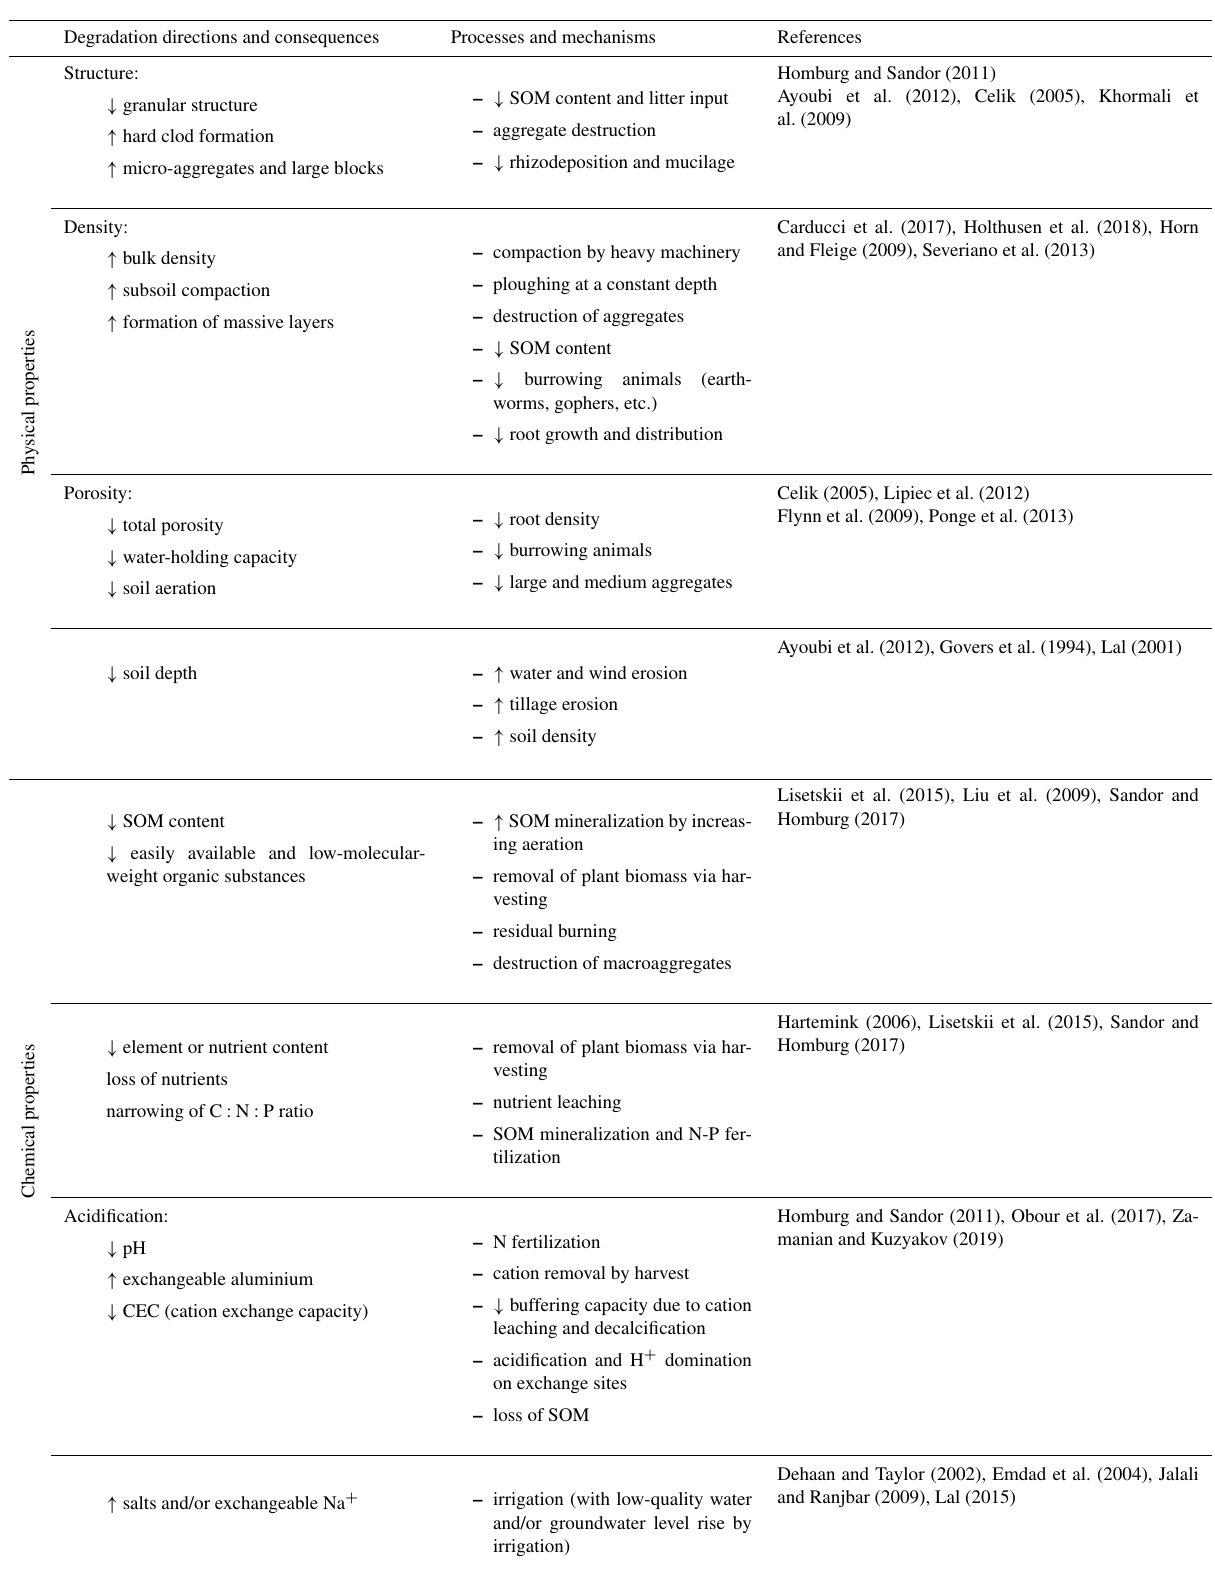
Table 1. Processes and mechanisms of soil degradation by agricultural land use. Degradation directions and